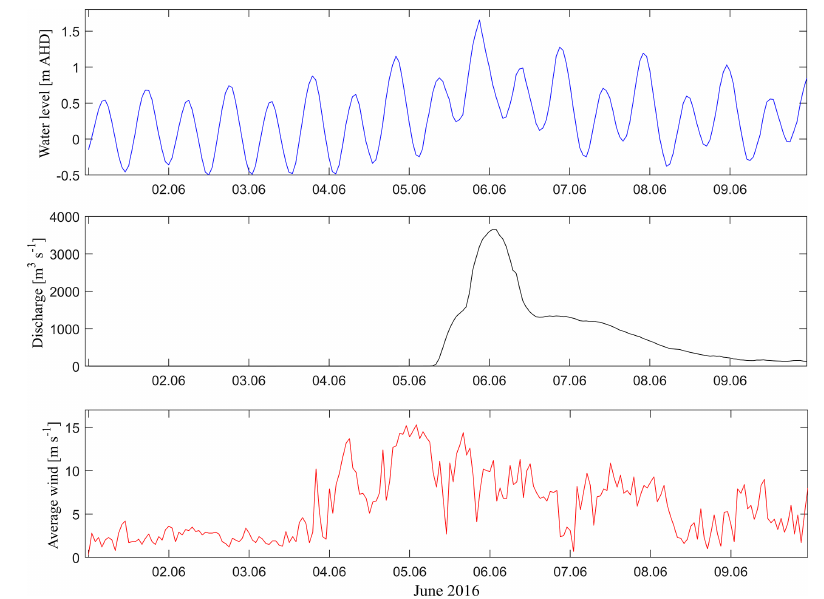
Figure 3. Hydrological and meteorological model forcing taken from observational data of the June 2016 storm event. Water level measure- ments originate from Crookhaven Heads gauge, discharge measurements from Tallowa dam and wind measurements from Port